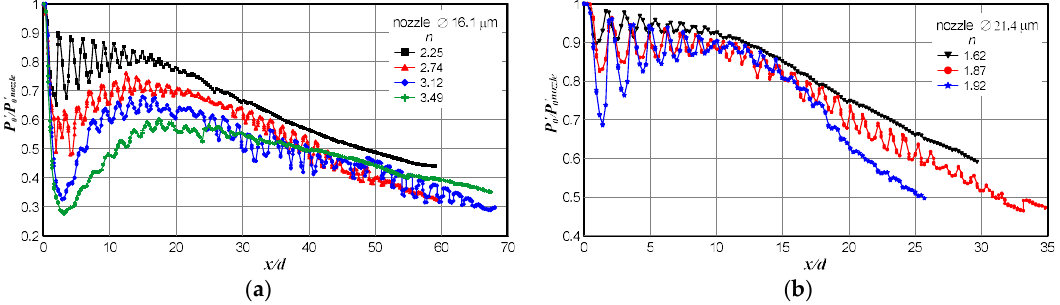
Figure 9. Pressure distributions in real microjets escaping from nozzles 21.4 ( a ) and 16.1 µ m in diameter ( b ).